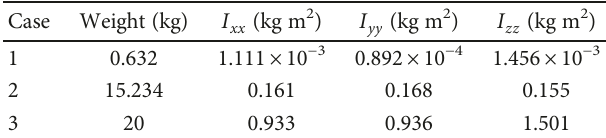
Figure 2: The shape and size of the storage tank and the position of the installation in the satellite: (a) the storage tank model; (b) the storage tank and microsatellite coupling model; (c) the storage tank and microsatellite with a deployment mechanism coupling Table 1: The moment of inertia of three cases.